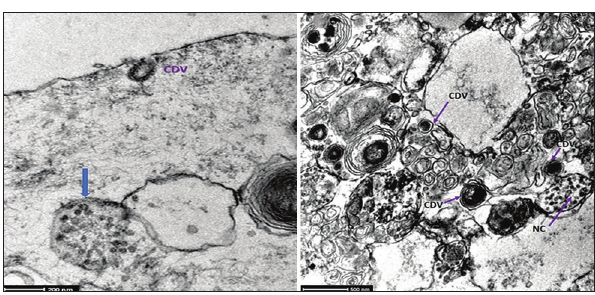
Figure-7: Transmission electron microscopy of adipose stem cell infected with canine distemper virus. (a) Intracytoplasmic nucleocapsid (arrow). Canine distemper virus: Virion in the cell periphery. (b) Cytoplasmic inclusion with viral nucleocapsids.